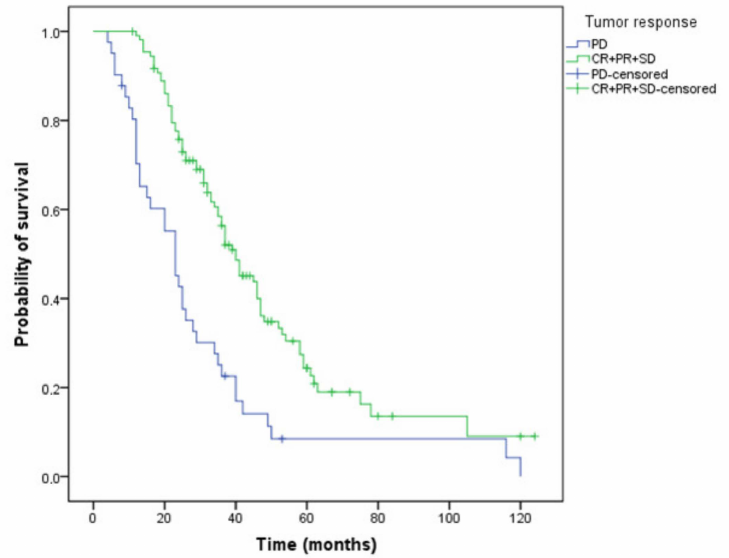
Figure 4. Kaplan–Meier curve of overall survival for patients who have or have not obtained a tumor response (OS, 40 versus 23 months, p < 0.001, PD—progressive disease, CR—complete response, PR- partial response, SD—stabile